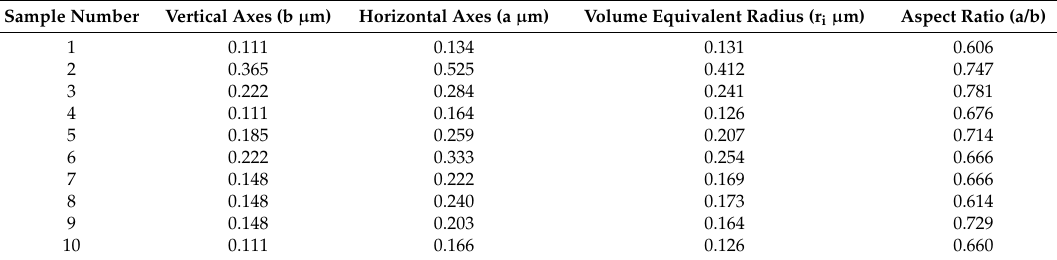
Table 2. Input data from images of filter samples from open fire.